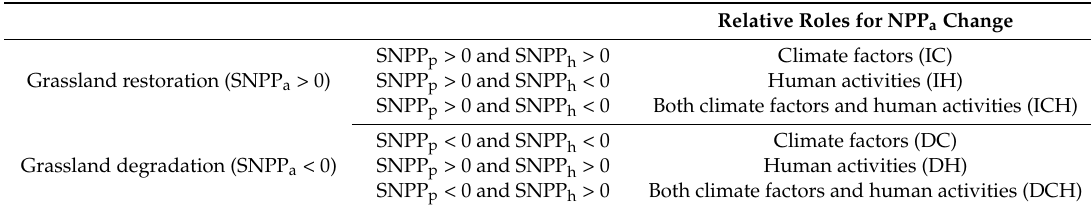
Table 1. Six scenarios of climate and human activities on grassland restoration and